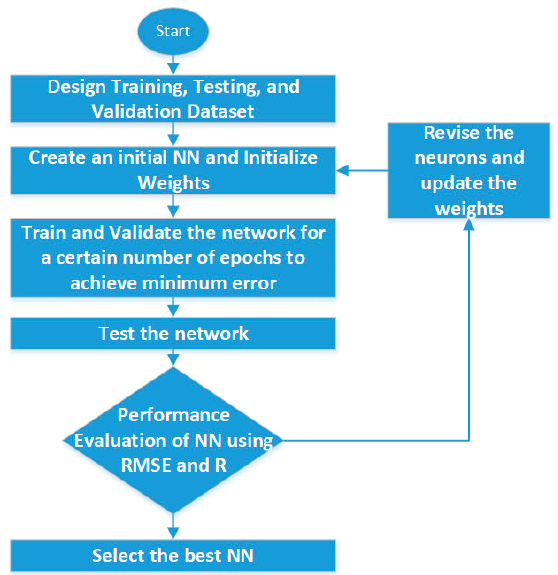
Figure 8. Flow of ANN model for the prediction of soil shear strength.